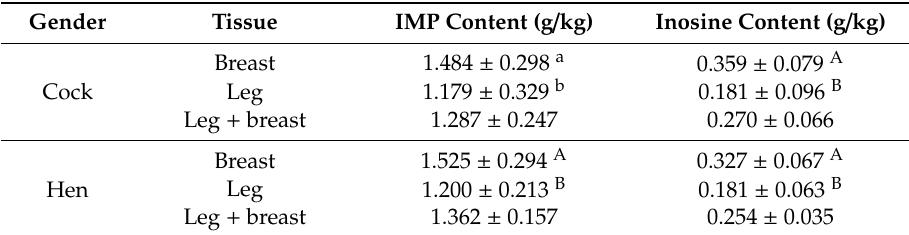
Table 3. Determination of inosine and inosine monophosphate (IMP) content.